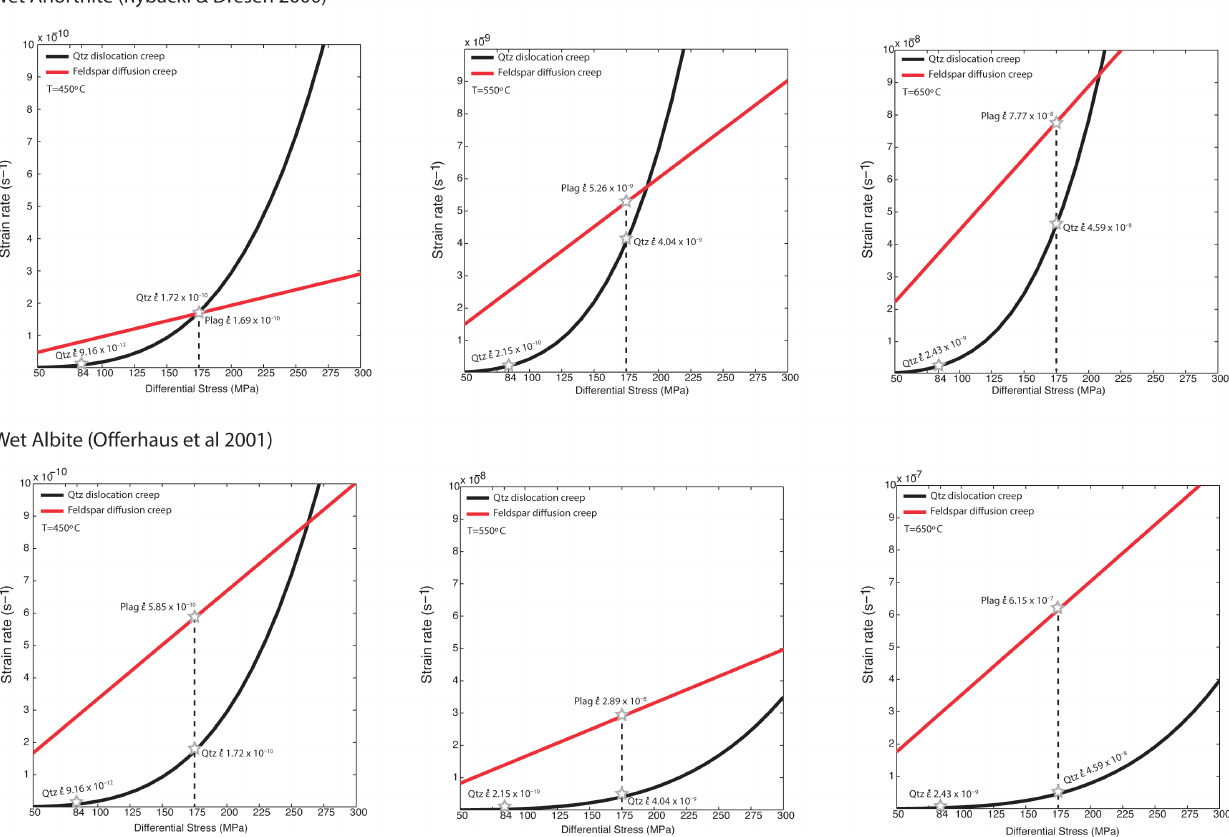
Figure 15. Plots of strain rate vs. differential stress for wet anorthite and wet albite aggregates deforming by diffusion creep and for quartz deforming by dislocation creep. See text for